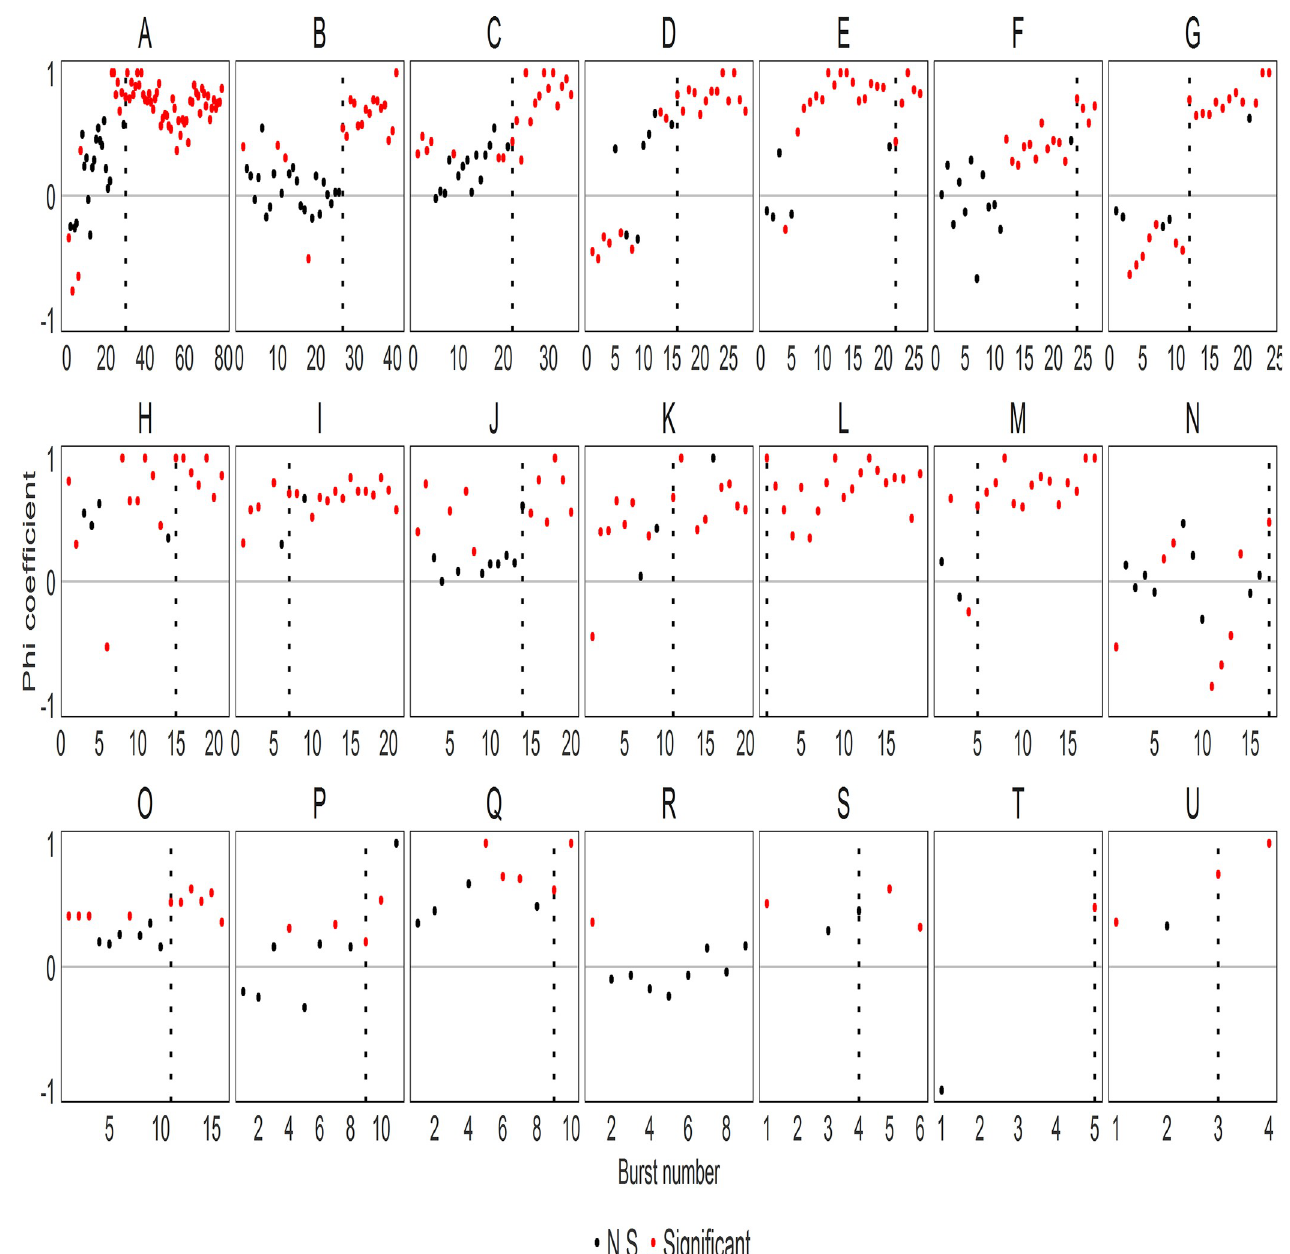
Fig 3. Phi-coefficient of aggressive and subordinate behavior by burst number within each dyad. Black dotted vertical lines represent when relationships are resolved according to phi-coefficient method. Red dots demonstrate significantly distinct levels of aggression versus subordinate behavior by each partner. Note that we excluded any bursts with less than 6 behavior bouts to determine the relationship resolution but those bursts are still shown in the